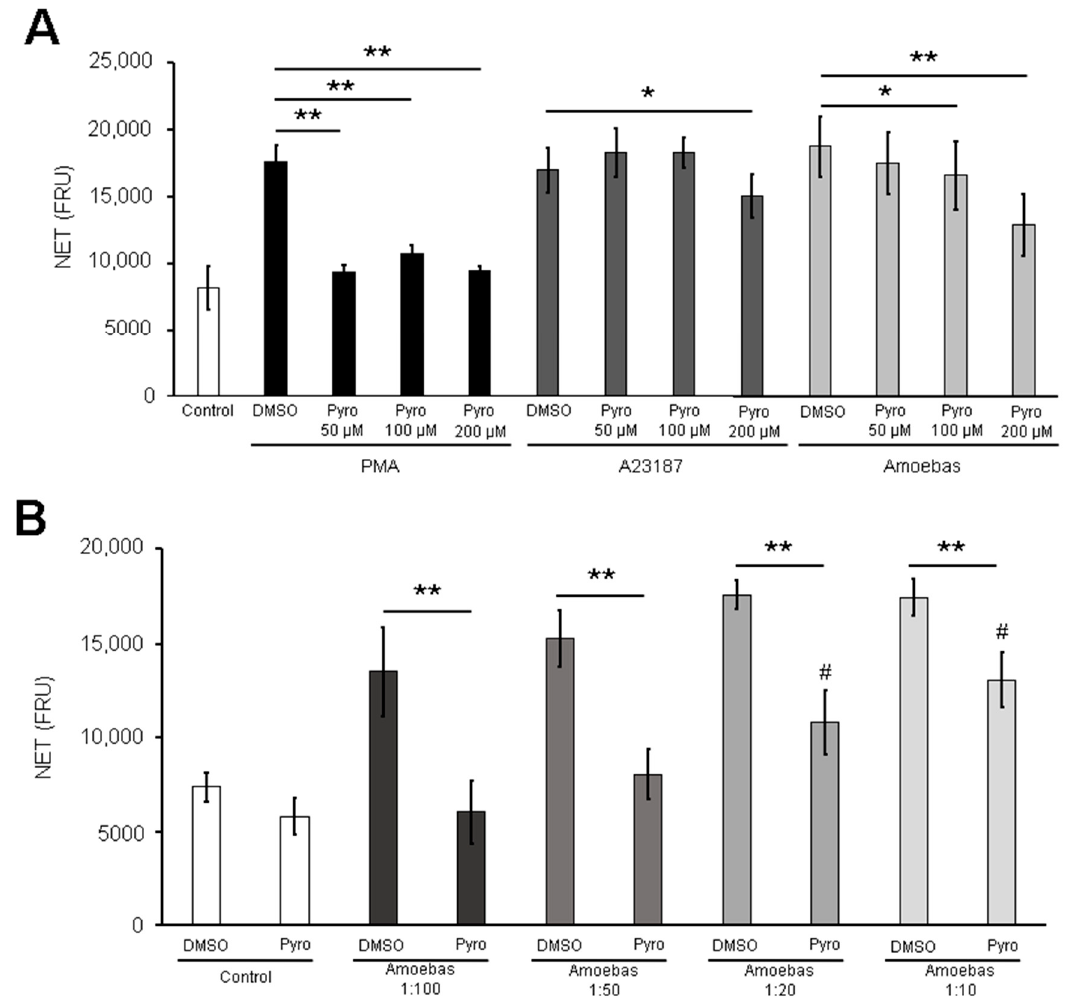
Figure 5. ROS-reduced trophozoites failed to induce NETosis on human neutrophils. ( A ) Neutrophils (1 × 10 5 ) were cultured in RPMI-1640 medium supplemented with 5% FBS, 500 nM SYTOX ® Green and pyrocatechol (Pyro, 50, 100 or 200 µ M or DMSO). Cells were stimulated with PMA (50 nM), A23187 (10 µ M) or 5 × 10 3 pyrocatechol-pretreated trophozoites (according to the concentration present in the medium). Fluorescence was read after 4 h. ( B ) Neutrophils (1 × 10 5 ) were cultured in RPMI-1640 medium supplemented with 5% FBS, 500 nM SYTOX ® Green and pyrocatechol (200 µ M or DMSO). Cells were stimulated with trophozoites pretreated with pyrocatechol (200 µ M or the vehicle DMSO) at ratios 1:100, 1:50, 1:20 or 1:10. Fluorescence was read after 4 h. NET amount is expressed in fluorescence relative units (FRU). Values are means ± SD of three independent experiments. * p < 0.01, ** p < 0.0001, # p < 0.05 with respect to the control.